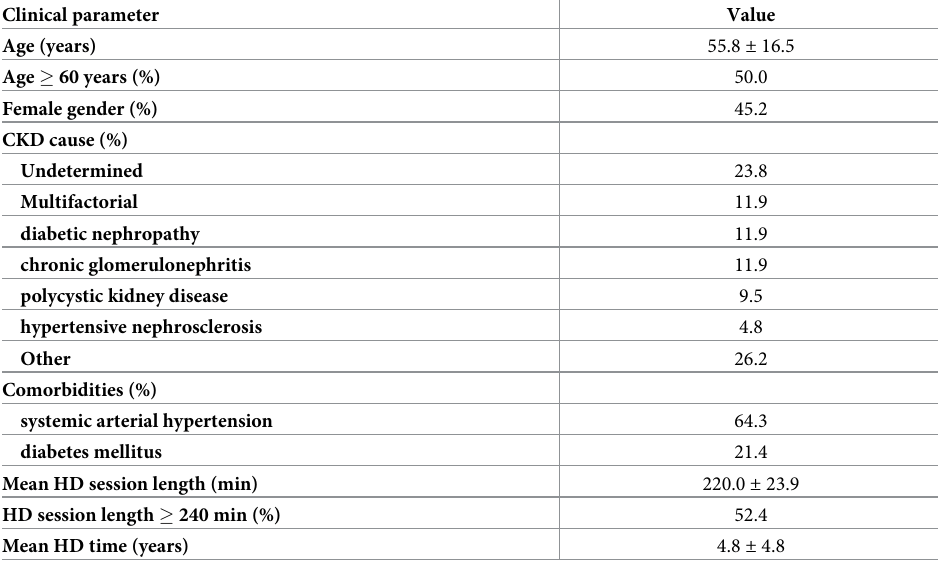
Table 1. Clinical characteristics of the study patients � . Clinical